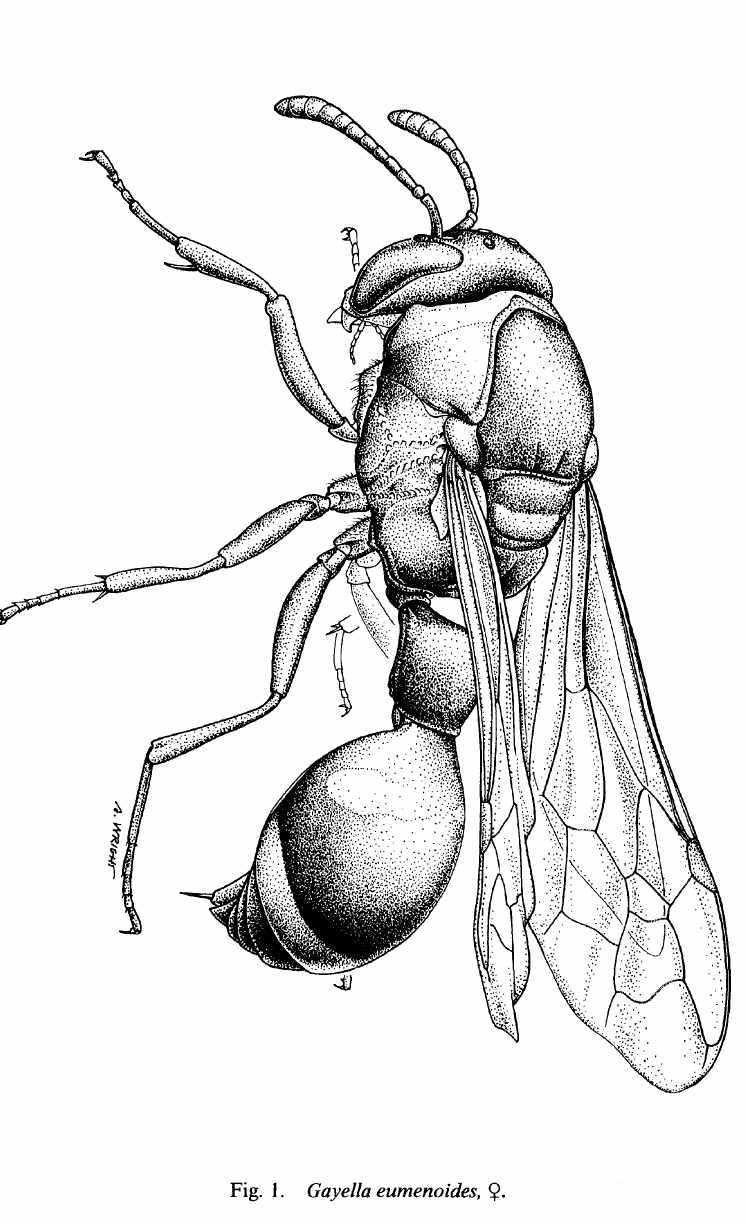
Fig. 1. Gayella eumenoides,